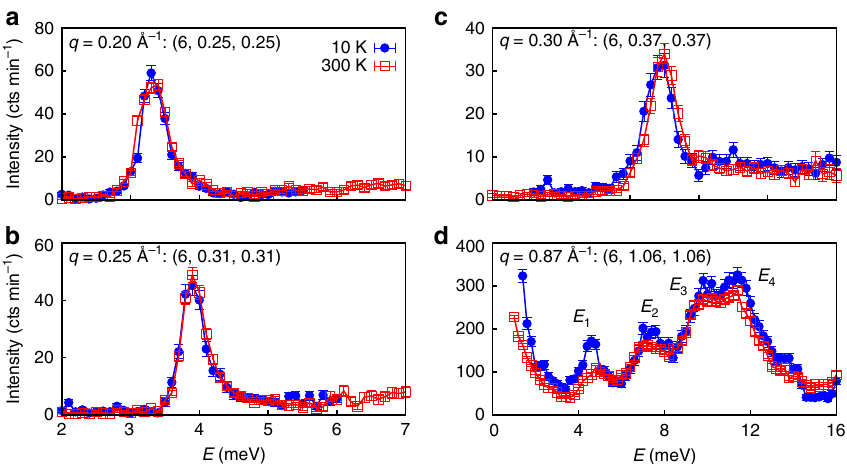
Fig. 6 Transverse acoustic (TA) phonons pro fi les measured at 10 and 300 K in Ba 7.81 Ge 40.67 Au 5.33 . a – c Comparison between constant q -scans of the TA 100 branch measured at 10 K ( full blue circles ) and 300 K ( red squares ) on the triple axis spectrometer (called 2T@LLB) with an effective resolution of 200 μ eV. d Similar comparison between scans with a larger resolution of 1.2 meV measured at the wave vector (6, 1.06, 1.06) close to the centre of the BZ where the four optic phonon modes, labeled E 1,2,3,4 in the text, are clearly visible ( a , b ). In a – d , the intensities are corrected for the Bose population factor. Vertical error bars are s.d. from counting statistics